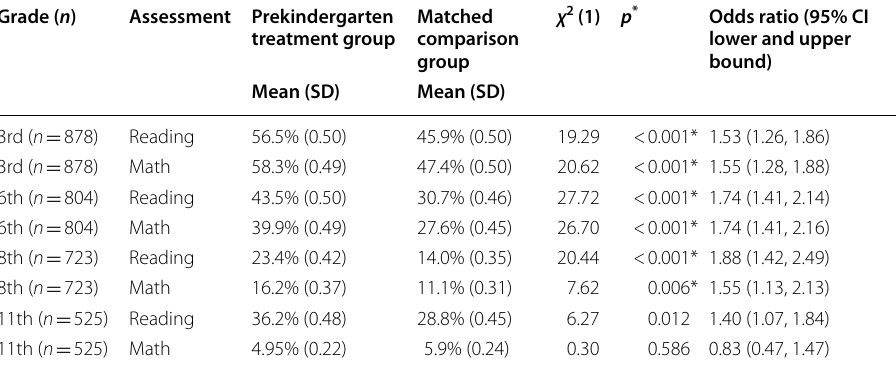
*Denotes significant chi-square test after Bonferroni correction (α significance